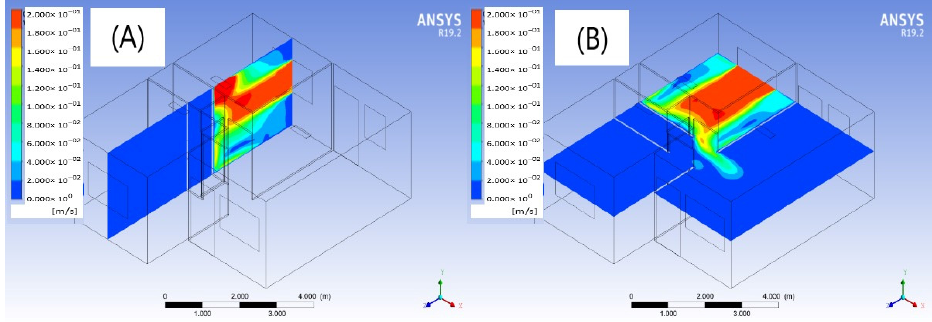
Figure 12. Velocity magnitude in the z–y plane ( A ) and in the z–x plane ( B ) for a rectangular channel, with the air outlet concentrated in room 2.